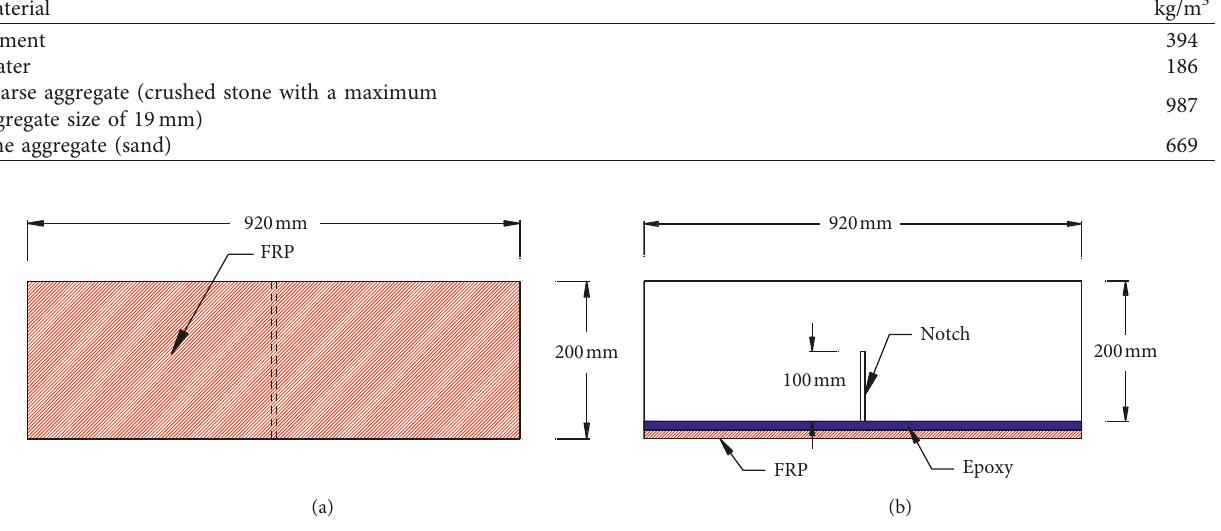
Figure 1: Sample dimensions. (a) Plan. (b) Elevation.